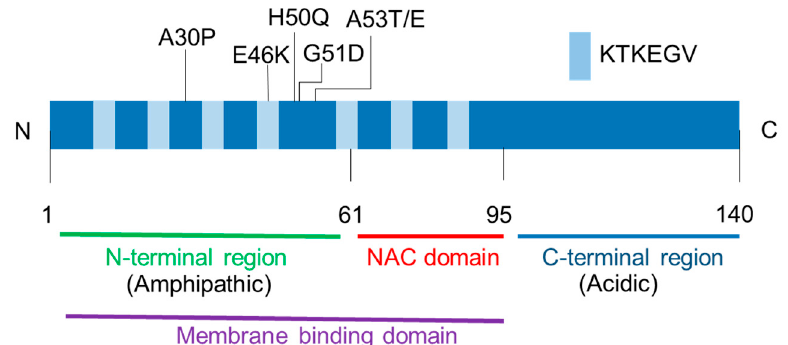
Figure 1. Alpha-synuclein protein structure. The N-terminal region and the non-amyloid-component (NAC) domain have seven imperfect KTKEGV repeats that contribute to membrane binding. All missense mutations linked to the familial Parkinson’s disease (A30P, E46K, H50Q, G51D, A53T, and A53E) are located in the N-terminal region.